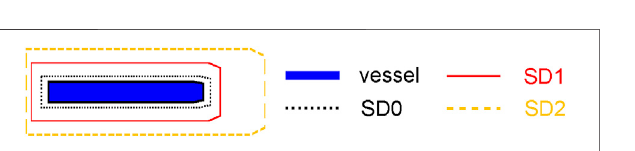
FIGURE 5 | Vessel, represented as a blue polygon and surrounded by ship domains, in local ENU frame, at position (0,0).